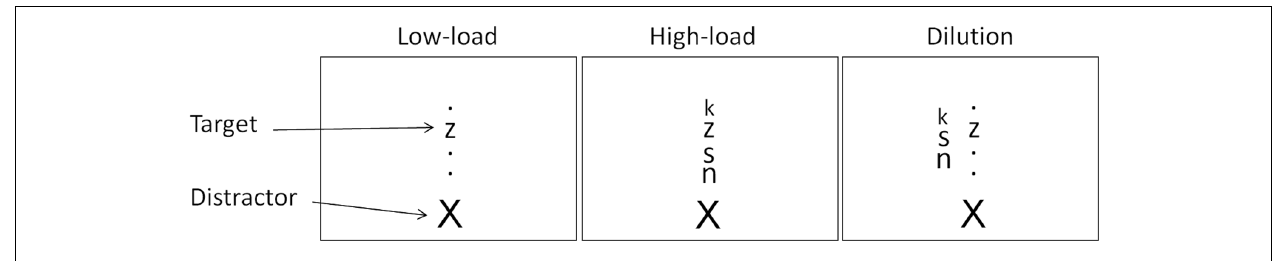
condition the target appeared alone in the target array with the three non-target letters appearing to the left or the right of the target array. All conditions included the presentation of distractor above or below the target array. Patients were instructed to ignore the identity of the distractor.